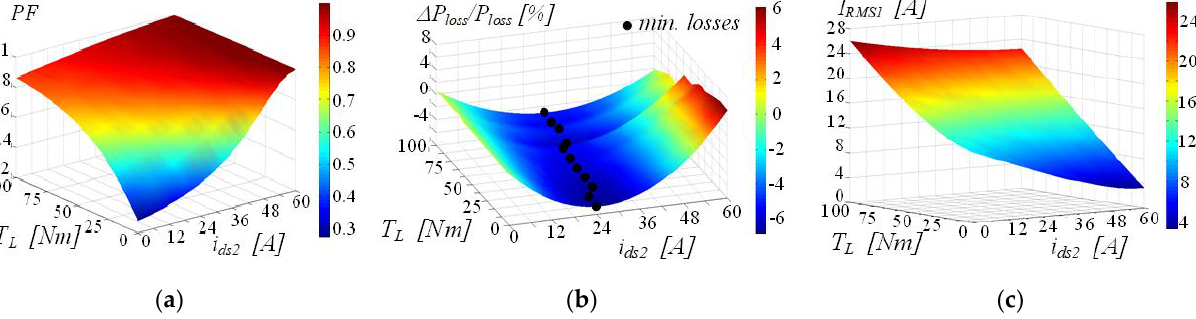
Figure 10. ( a ) PF , ( b ) Δ P loss , ( c ) root mean square (RMS) value of the main winding current I RMS1 , determined under different loads T L .